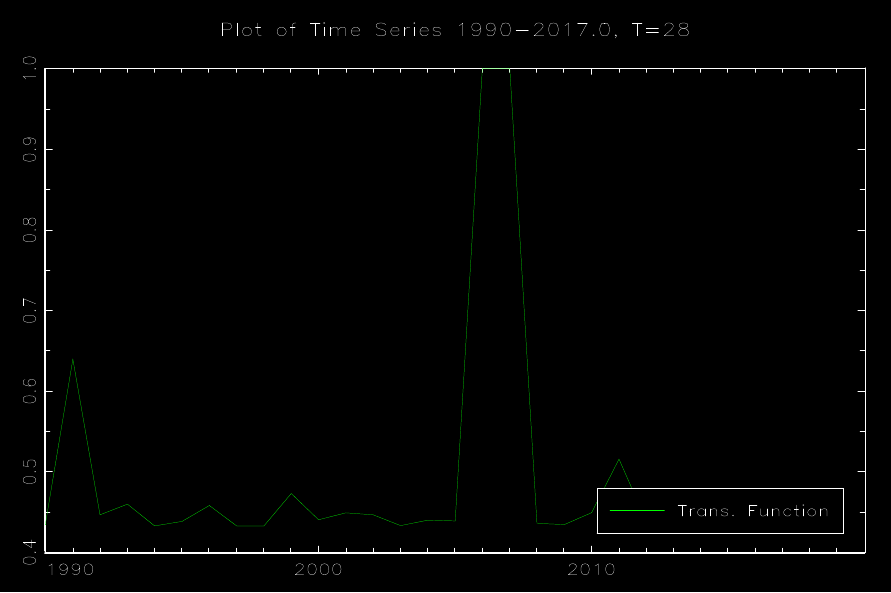
Figure 5. Time series diagram of the zone conversion.